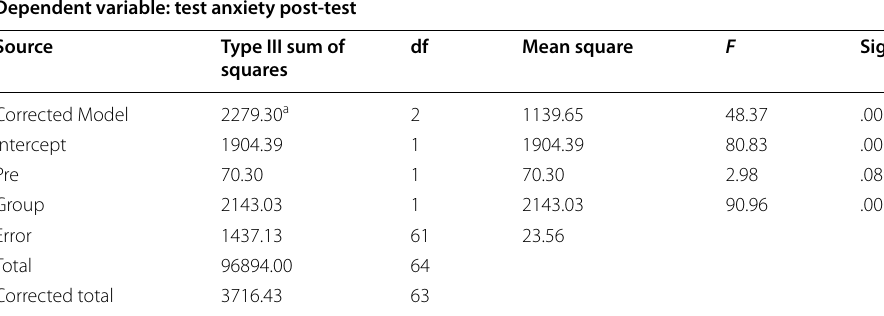
Table 8 Test anxiety inferential